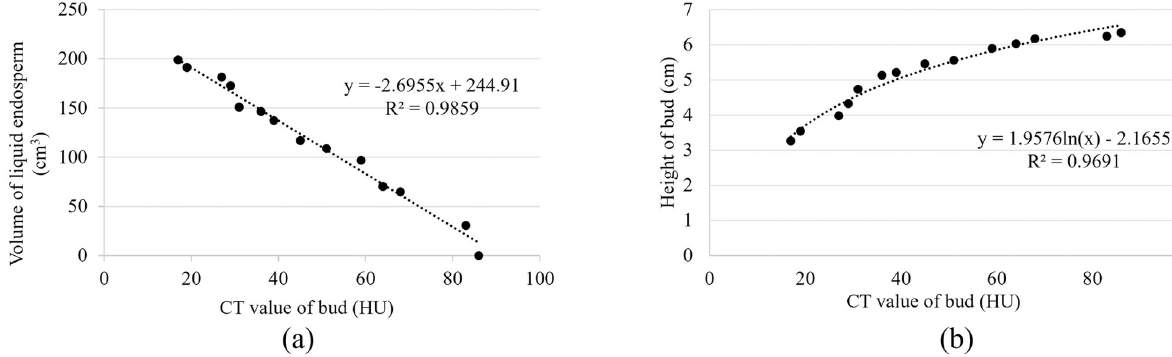
Fig 10. Regression analysis of the measurements of